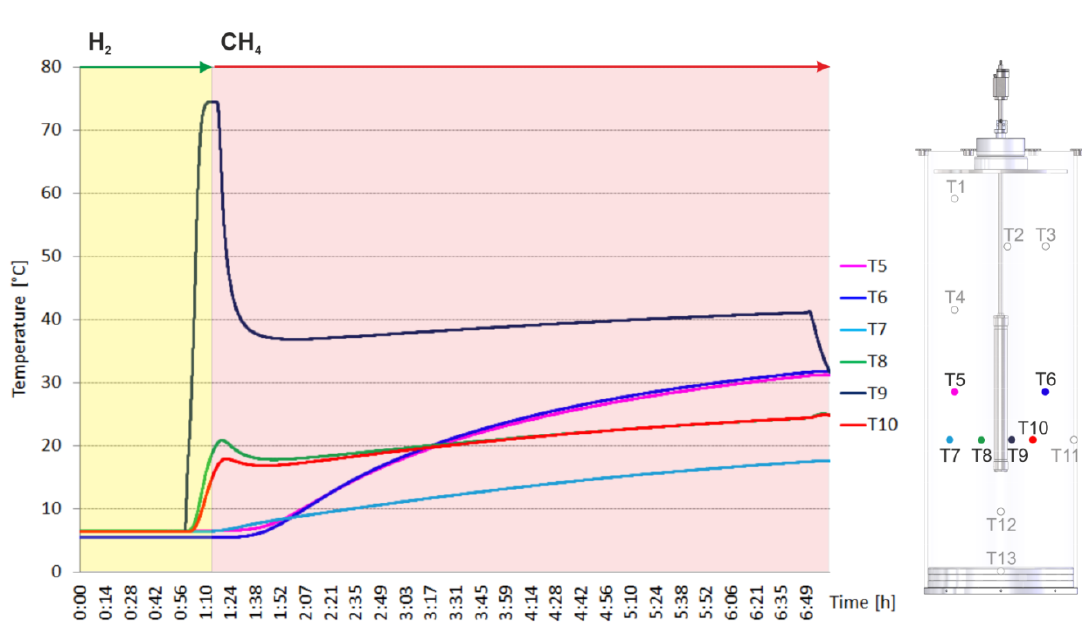
Figure 3. Left: Temperature profiles versus time for heating experiments using the reactor in sediment + water with external cooling (4 °C). Right: Positions of the temperature sensors within LARS, empty circles show positions of temperature sensors whose profiles are not shown in the left.